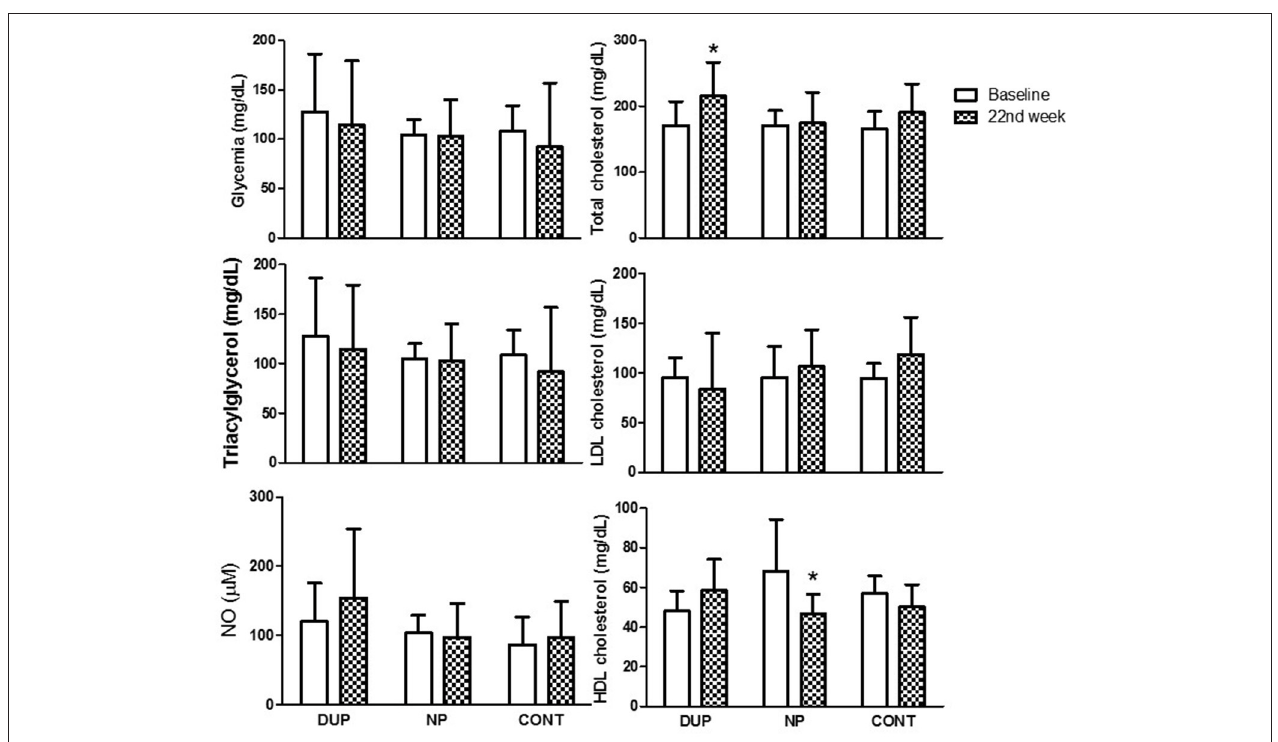
FIGURE 6 | Biochemical parameters of experimental groups. Values expressed as mean ± SD.NP, Non-periodized; DUP, Daily undulating periodization; CG, Control group; NO, Nitric oxide; LDL, Low-density lipoprotein; HDL, High-density lipoprotein. An ANOVA [3 × 2, groups × time] was used to examine differences between NP, DUP, and CG pre and